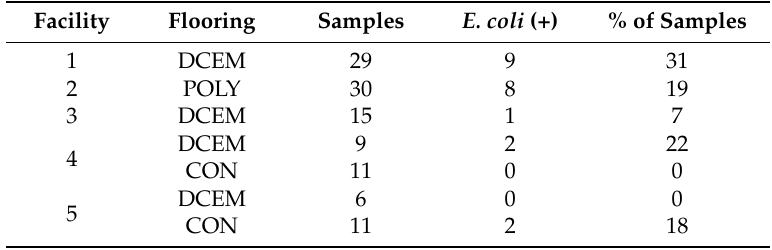
Table 7. Floor swabs. E. coli positive samples by facility and flooring type. DCEM: Diamond-shaped coated expanded metal; POLY: Polypropylene; and CON: